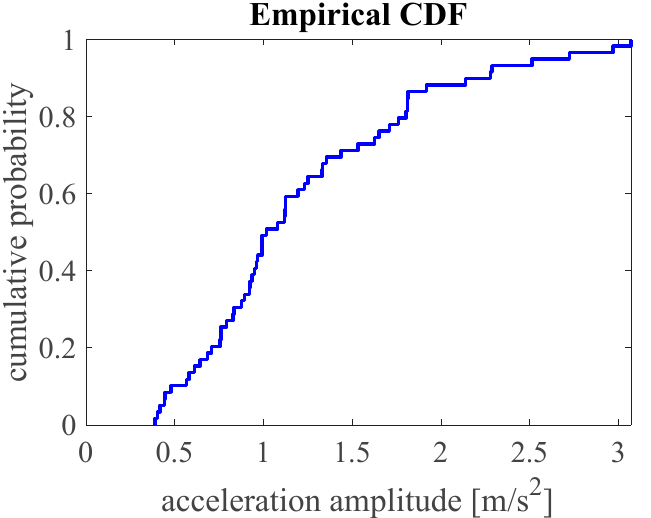
Figure 13. An empirical cumulative distribution function (CDF) plotted by the ‘cdfplot’ Matlab function, based on the 59 maximum acceleration amplitudes (intensity 7 as an example) induced by different ground accelerations in the vertical (Z) direction.